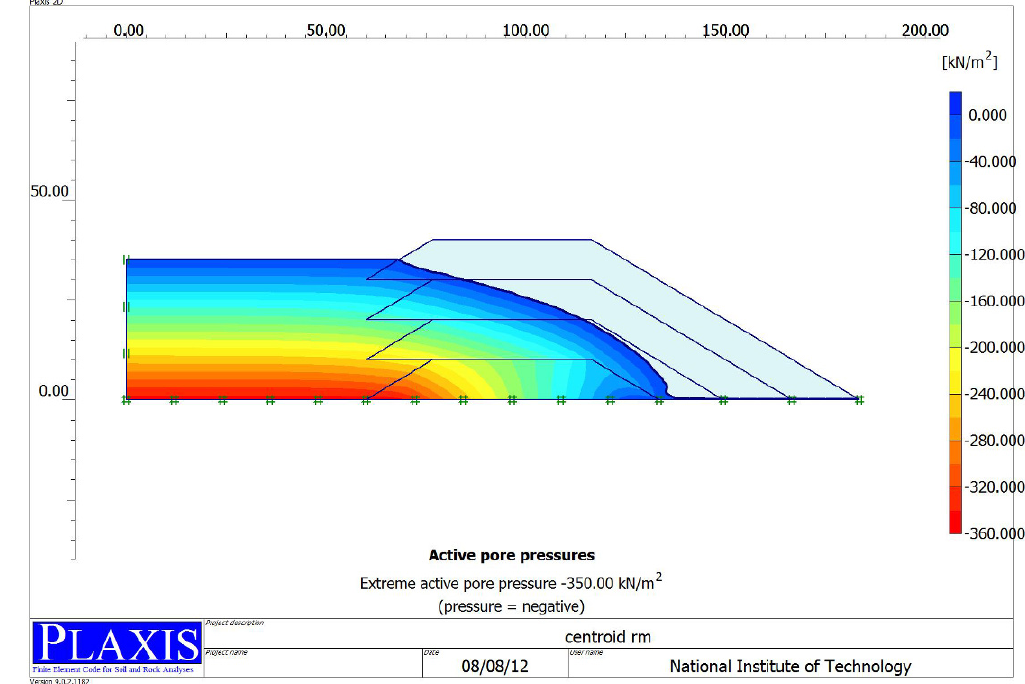
Figure 14. Cross section of centroid method dam with phreatic line and pore pressure